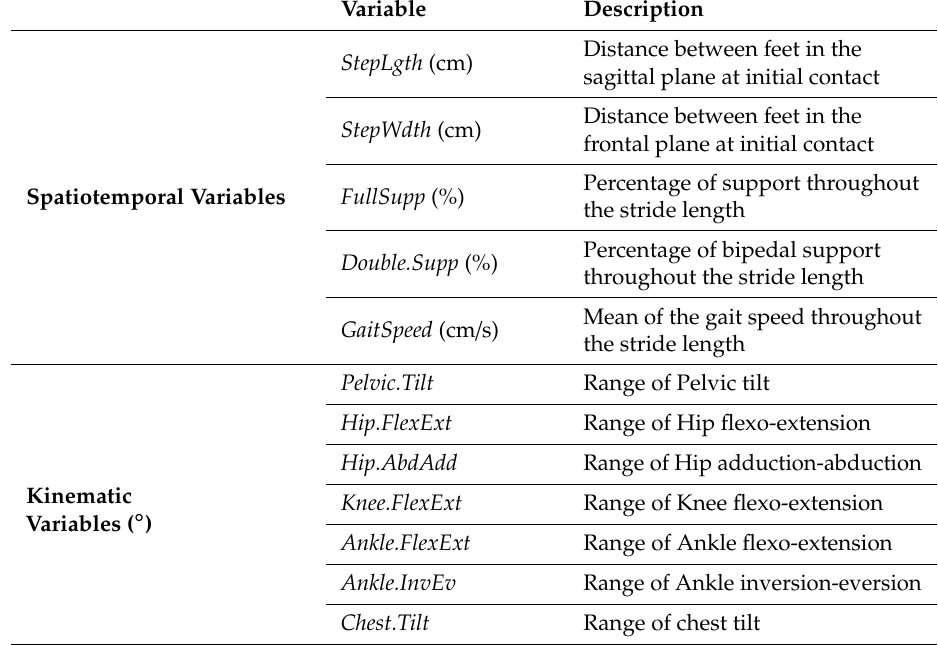
Table 2. Variables considered in the